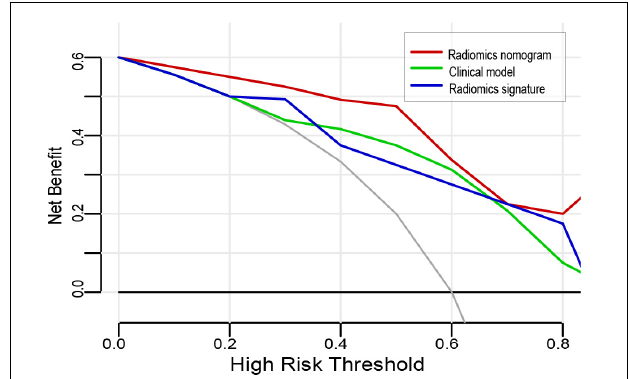
FIGURE 5 | Decision curve analysis for the three models. The y -axis indicates the net benefit; the x -axis indicates the threshold probability. The red line, green line, and blue line represent the net benefit of the radiomics nomogram, clinical model, and radiomics signature, respectively. The radiomics nomogram had the highest net benefit compared with the other two models when the threshold probability was < 0.8 at which a patient would be diagnosed as vascular malformations-related hemorrhage